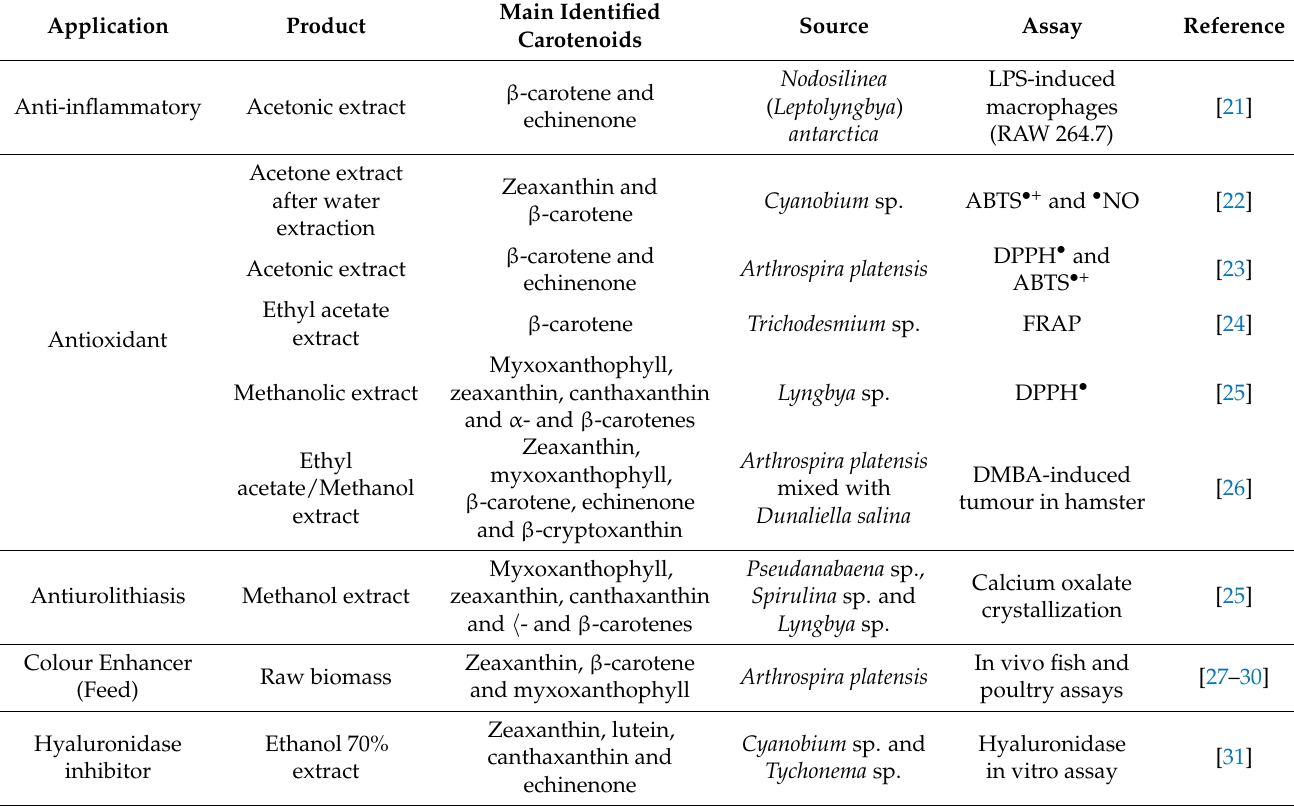
Table 1. Potential of carotenoids from cyanobacteria for biotechnological